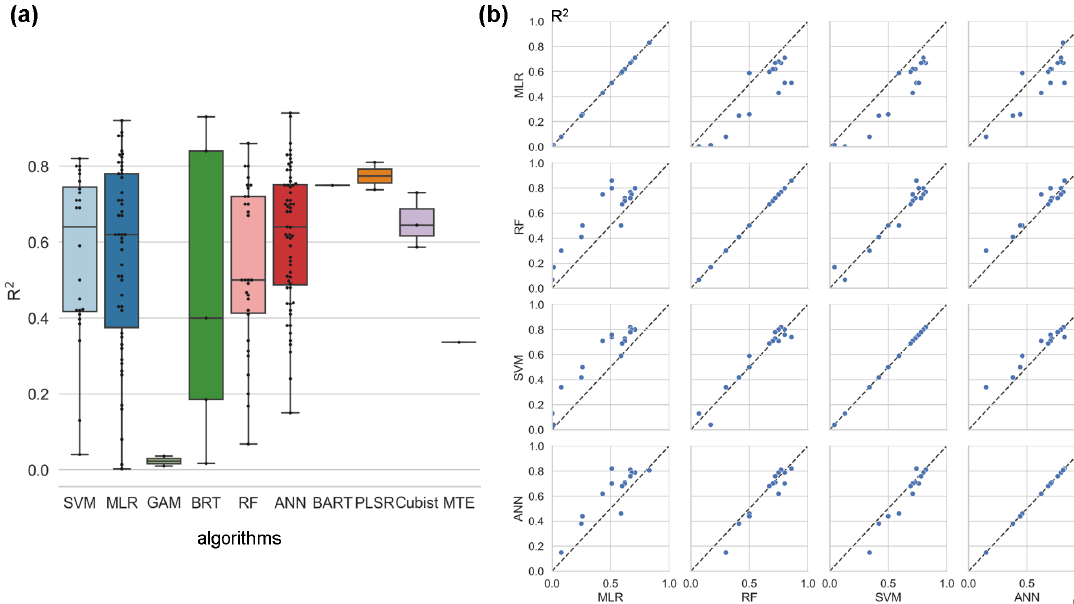
Figure 5. Differences in model accuracy ( R 2 ) using different algorithms across studies (a) and internal comparisons of the model accuracy ( R 2 ) of selected pairs of algorithms within individual studies (b) . Regression algorithms: random forest (RF), multiple linear regression (MLR), artificial neural network (ANN), support vector machine (SVM), partial least-squares regression (PLSR), generalized additive model (GAM), boosted regression tree (BRT), Bayesian additive regression tree (BART), cubist, model tree ensemble (MTE). In (a) the horizontal line in the box indicates the medians. The top and bottom border lines of the box indicate the 75th and 25th percentiles, respectively.